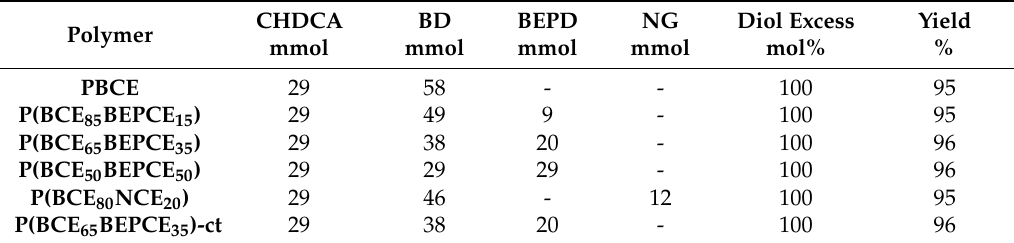
Table 1 . Starting reagent amounts, molar diol excess, and yield data for PBCE, P(BCE m BEPCE n ), and P(BCE 80 NCE 20 ) random copolymers.